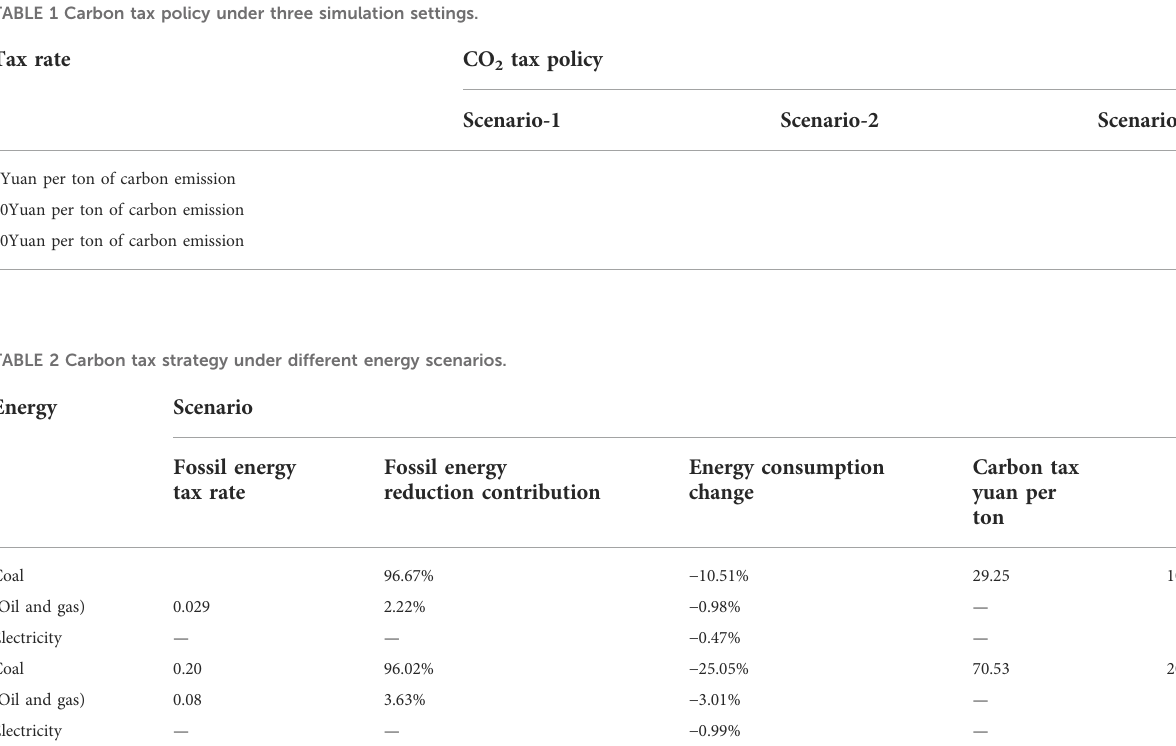
TABLE 1 Carbon tax policy under three simulation settings.